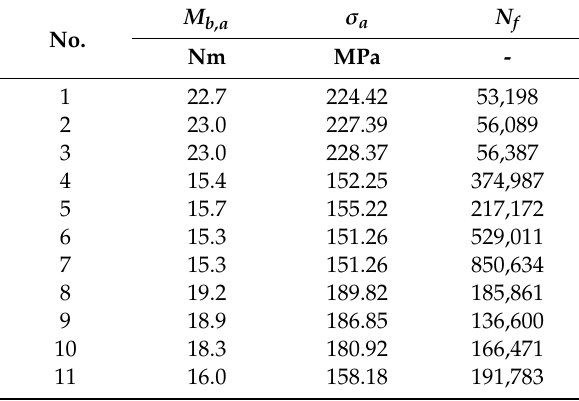
Table 6. Results of fatigue tests on samples after 7 days in a 3.5% NaCl solution in demineralised